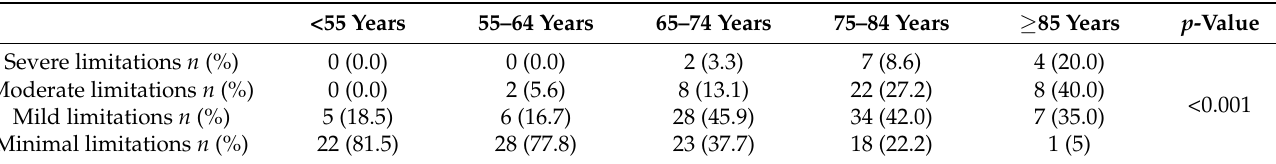
Table 3. Results of the SPPB according to age